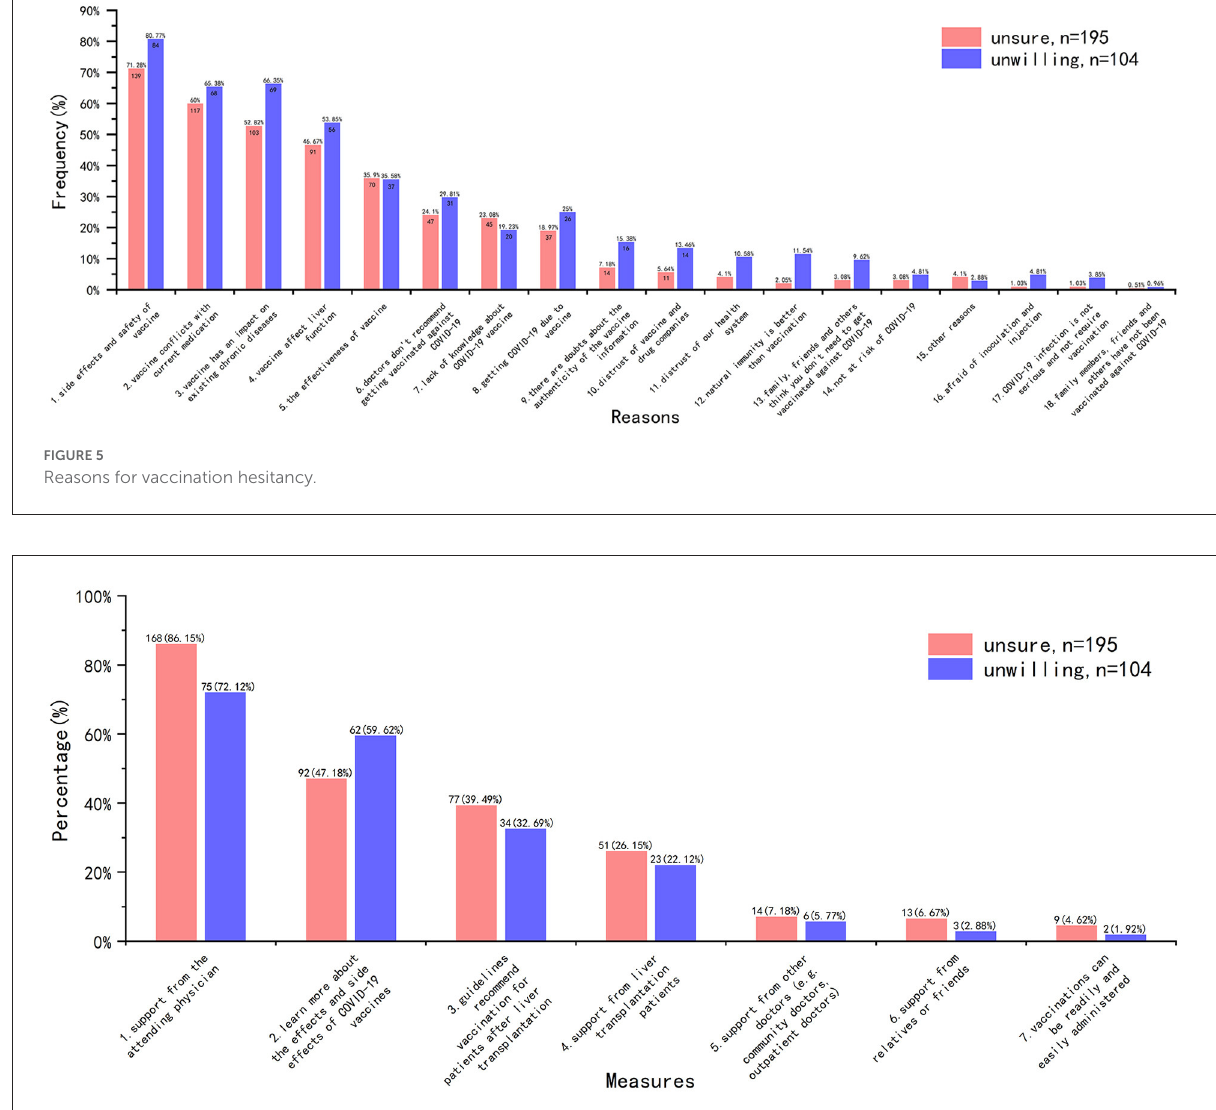
FIGURE6 Measures to improve COVID-19 vaccine